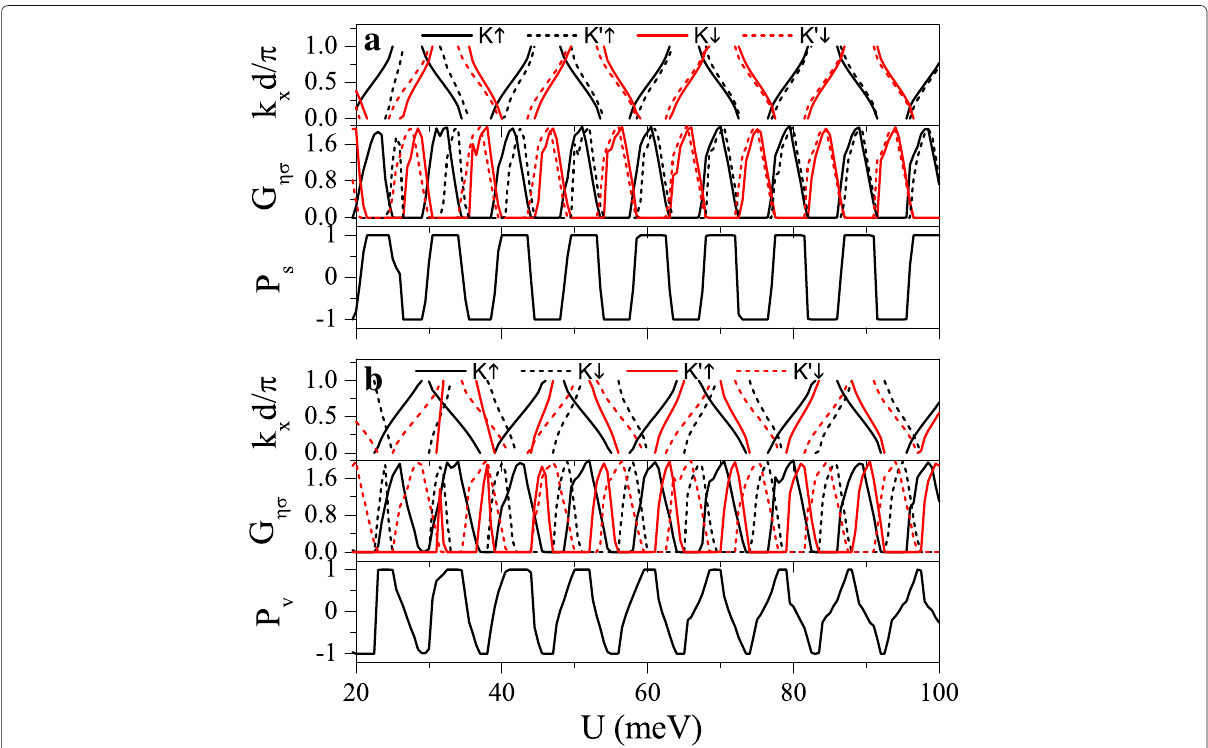
Fig. 8 Minibands, conductances G ησ , spin polarization P s , and valley polarization P v versus potential U . ( a ) (cid:2) z = 4.0 meV. ( b ) (cid:2) z = 12.0 meV. Other parameters are set as h = 7.0 meV, E = 6.0 meV, d b = d w = 120 nm, and n = 10